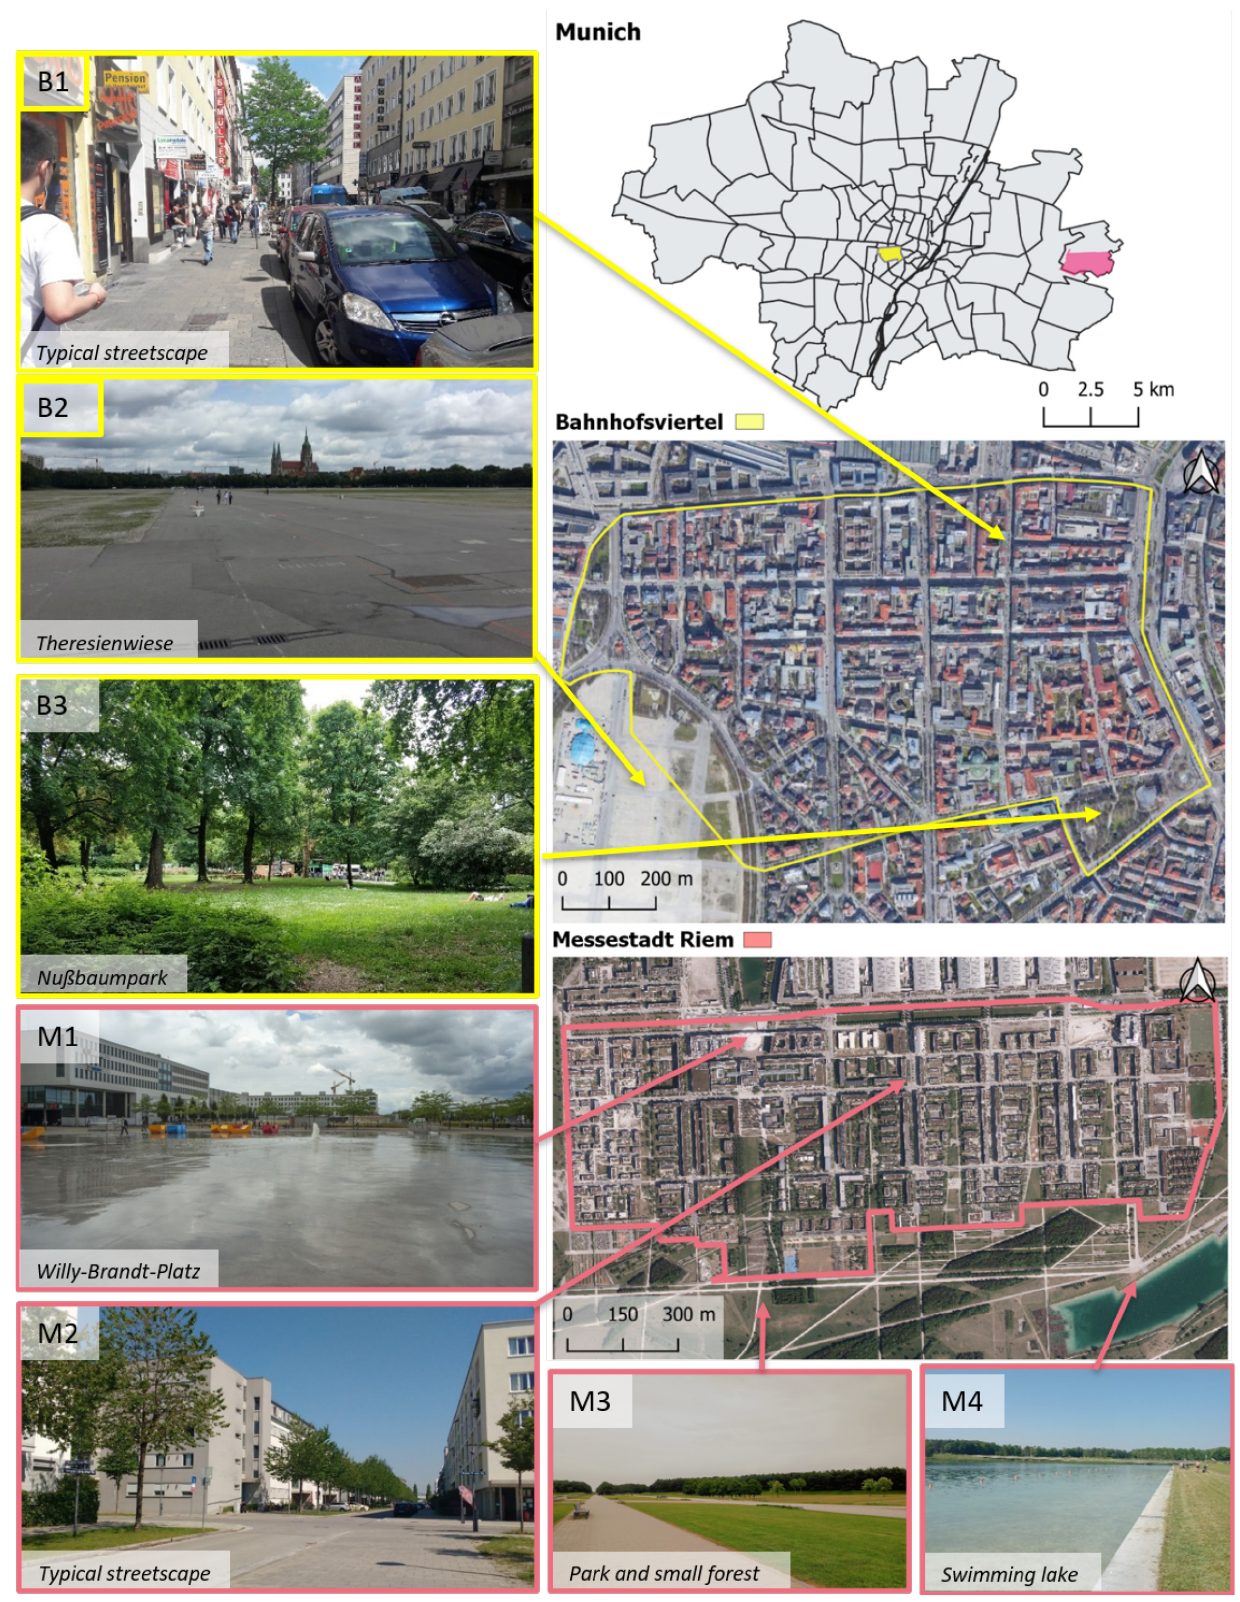
Figure 1. Pictures of distinctive sites of the study areas Bahnhofsviertel (B1–B3) and Messestadt (M1–M4), and their loca‐ tion within